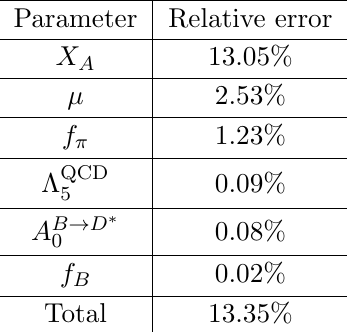
Table 1 . Error budget for the observable R D (cid:3) (cid:25)